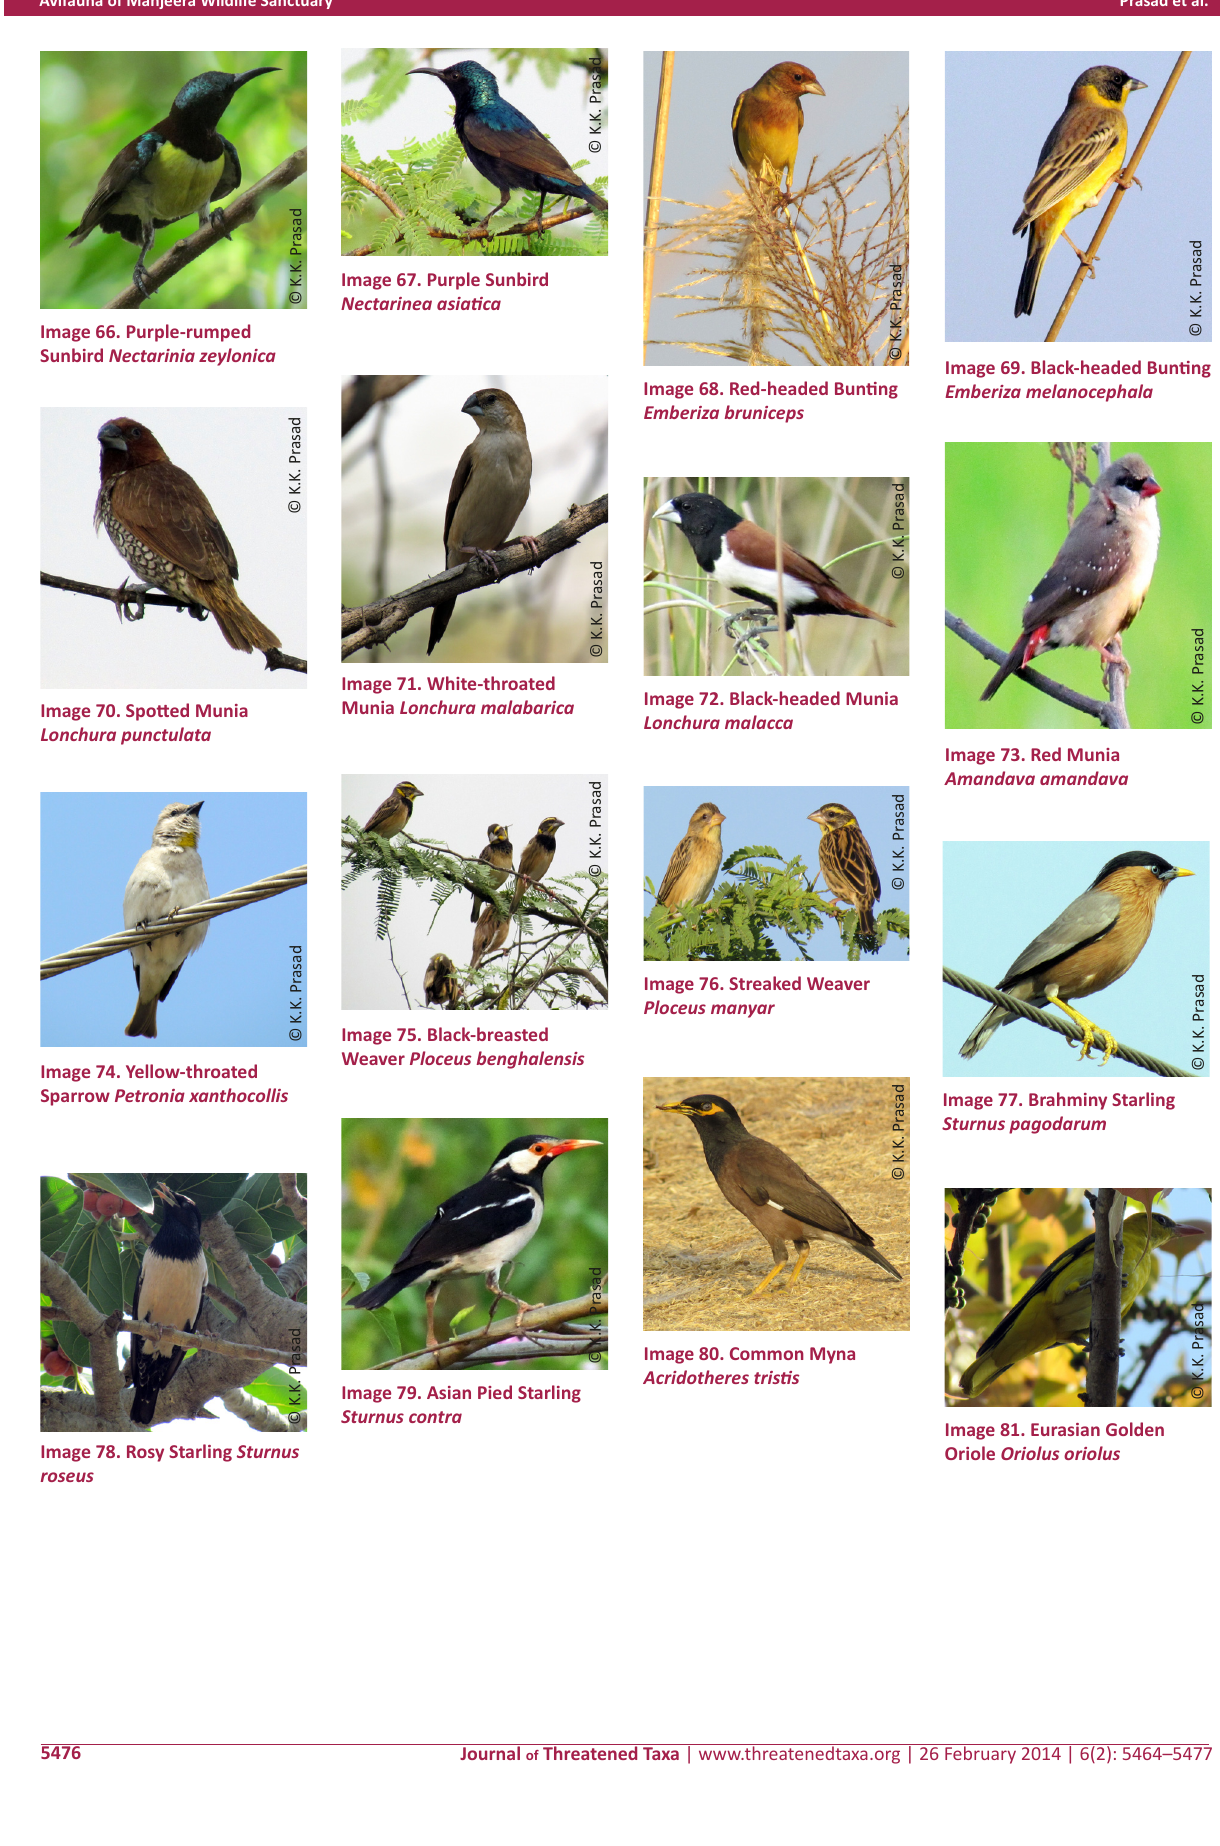
Image 67. Purple Sunbird Nectarinea asiatica